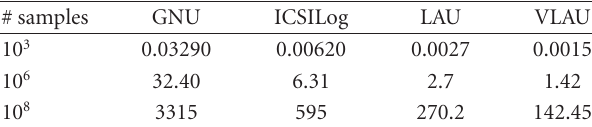
Table 6: Execution times (in ms) of GNU, ICSILog, LAU, and VLAU SP implementations for 10 3 up to 10 8